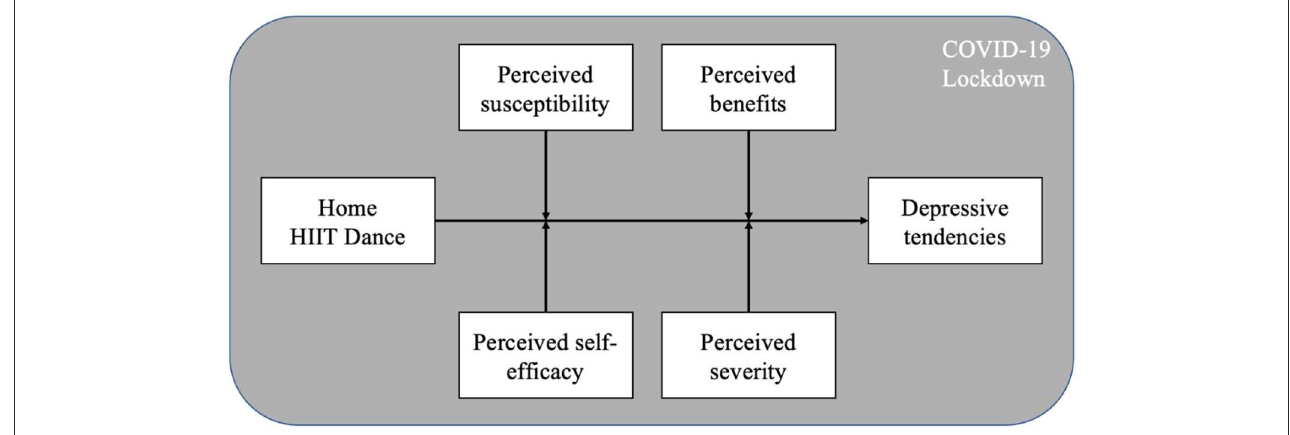
FIGURE1 Model of the relationship between home HIIT dance and depression during COVID-19